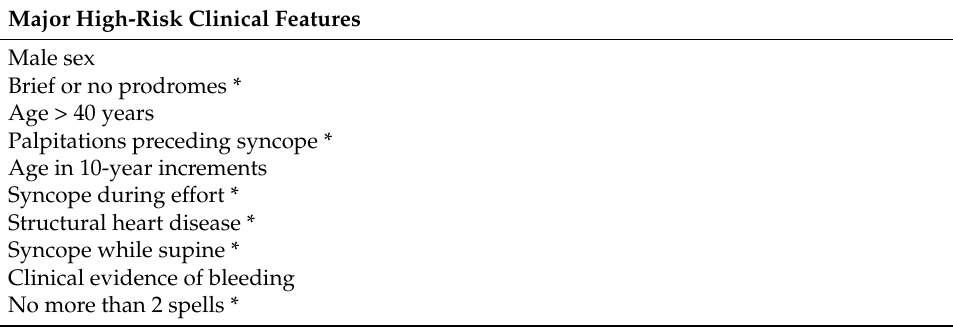
Table 1. High-risk historical features for syncope